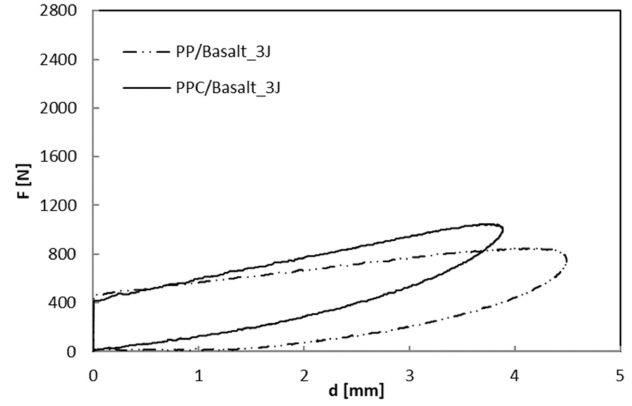
Figure 7. Load–displacement curves at indentation: comparison between BS_PP and BS_PPC; U = 3